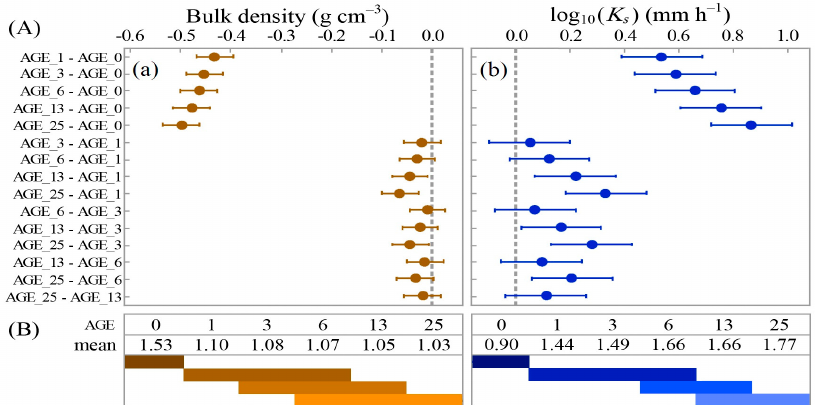
Figure 4. Results of the Tukey Honestly Significant Difference test for ( a ) the soil bulk density and ( b ) the log-transformed field saturated hydraulic conductivity ( K s ) values. ( A ) Multiple comparisons at 95% simultaneous confidence intervals of all pairs of groups. The circles represent difference between means; the confidence intervals represent the likely ranges for all the mean differences. If an interval does not contain zero, the corresponding means are significantly different. ( B ) The grouping information table highlights the significant and not significant comparisons. Each horizontal bar groups together members that are not statistically different.